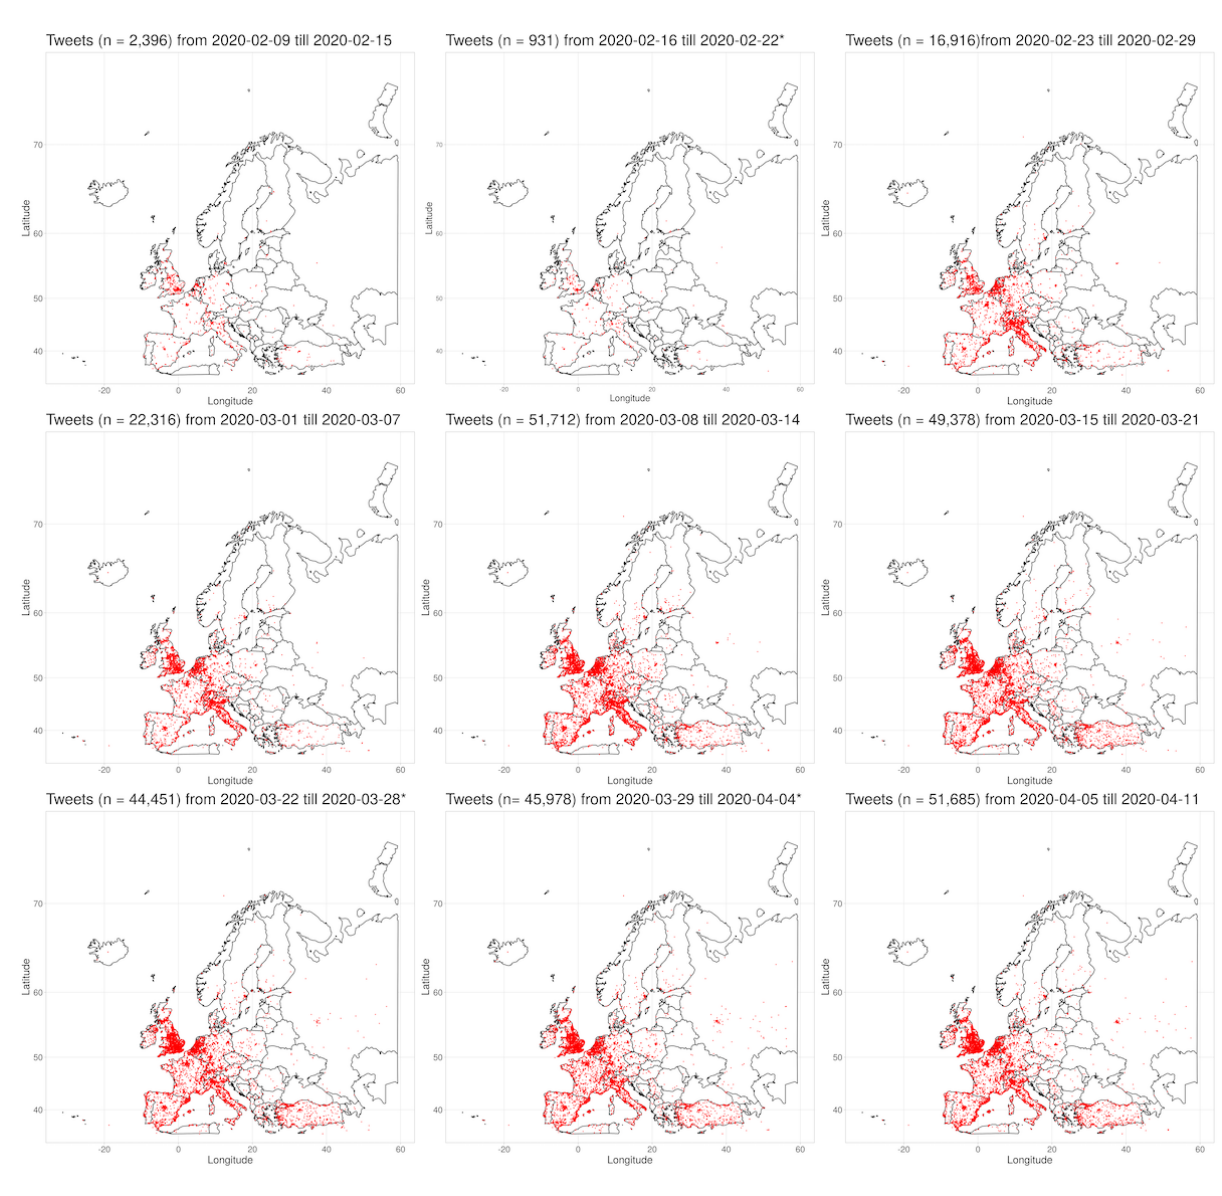
Figure 4. Geolocation information of COVID-19–related tweets depicted for each 7-day interval. From top left (February 9, 2020, to February 15, 2020) to bottom right (April 5, 2020, to April 11, 2020). A single red dot denotes one tweet. Tweets with the same geographical information are plotted on top of each other. *No tweets were collected between February 20, 2020, and February 22, 2020, and between March 28, 2020, and March 29, 2020, due to technical